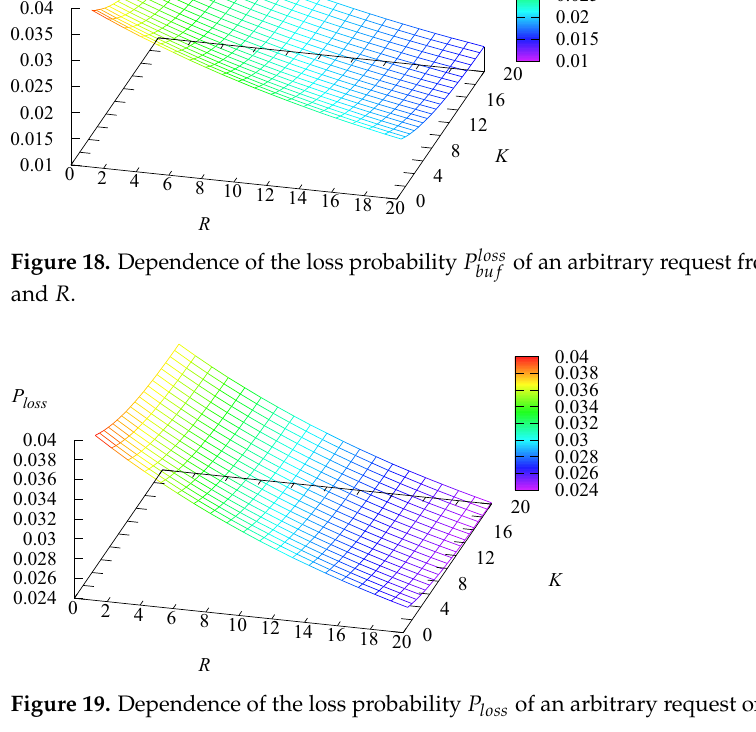
Figure 19. Dependence of the loss probability P loss of an arbitrary request on K and R